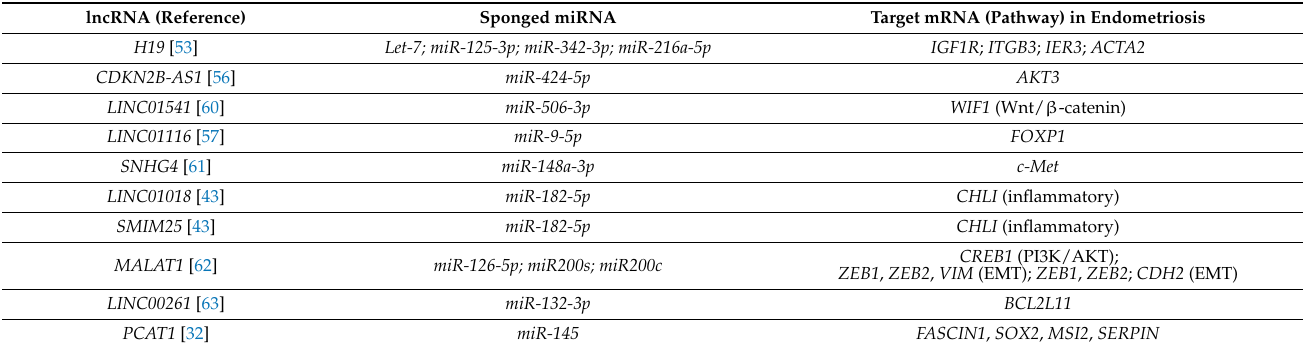
Table 2. LncRNAs involved in endometriosis as molecular sponges of